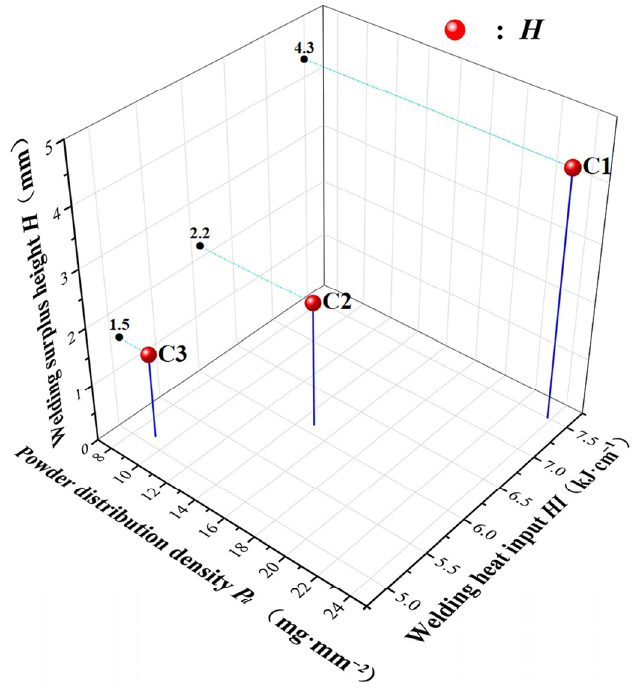
Figure 4. Influences of welding heat input (HI) and powder distribution density (P d ) on welding surplus height (H).